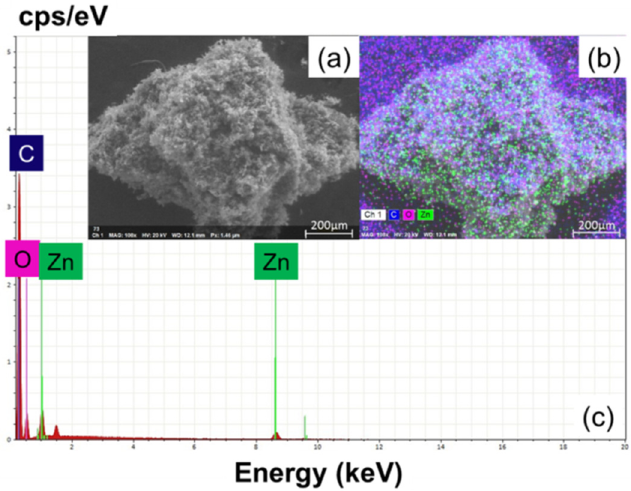
Figure 4. ( a ) Scanned region in the SEM micrographs of DB/ZnSt particles; ( b ) elemental mapping of the scanned area; ( c ) EDAX spectra of DB/ZnSt particles.